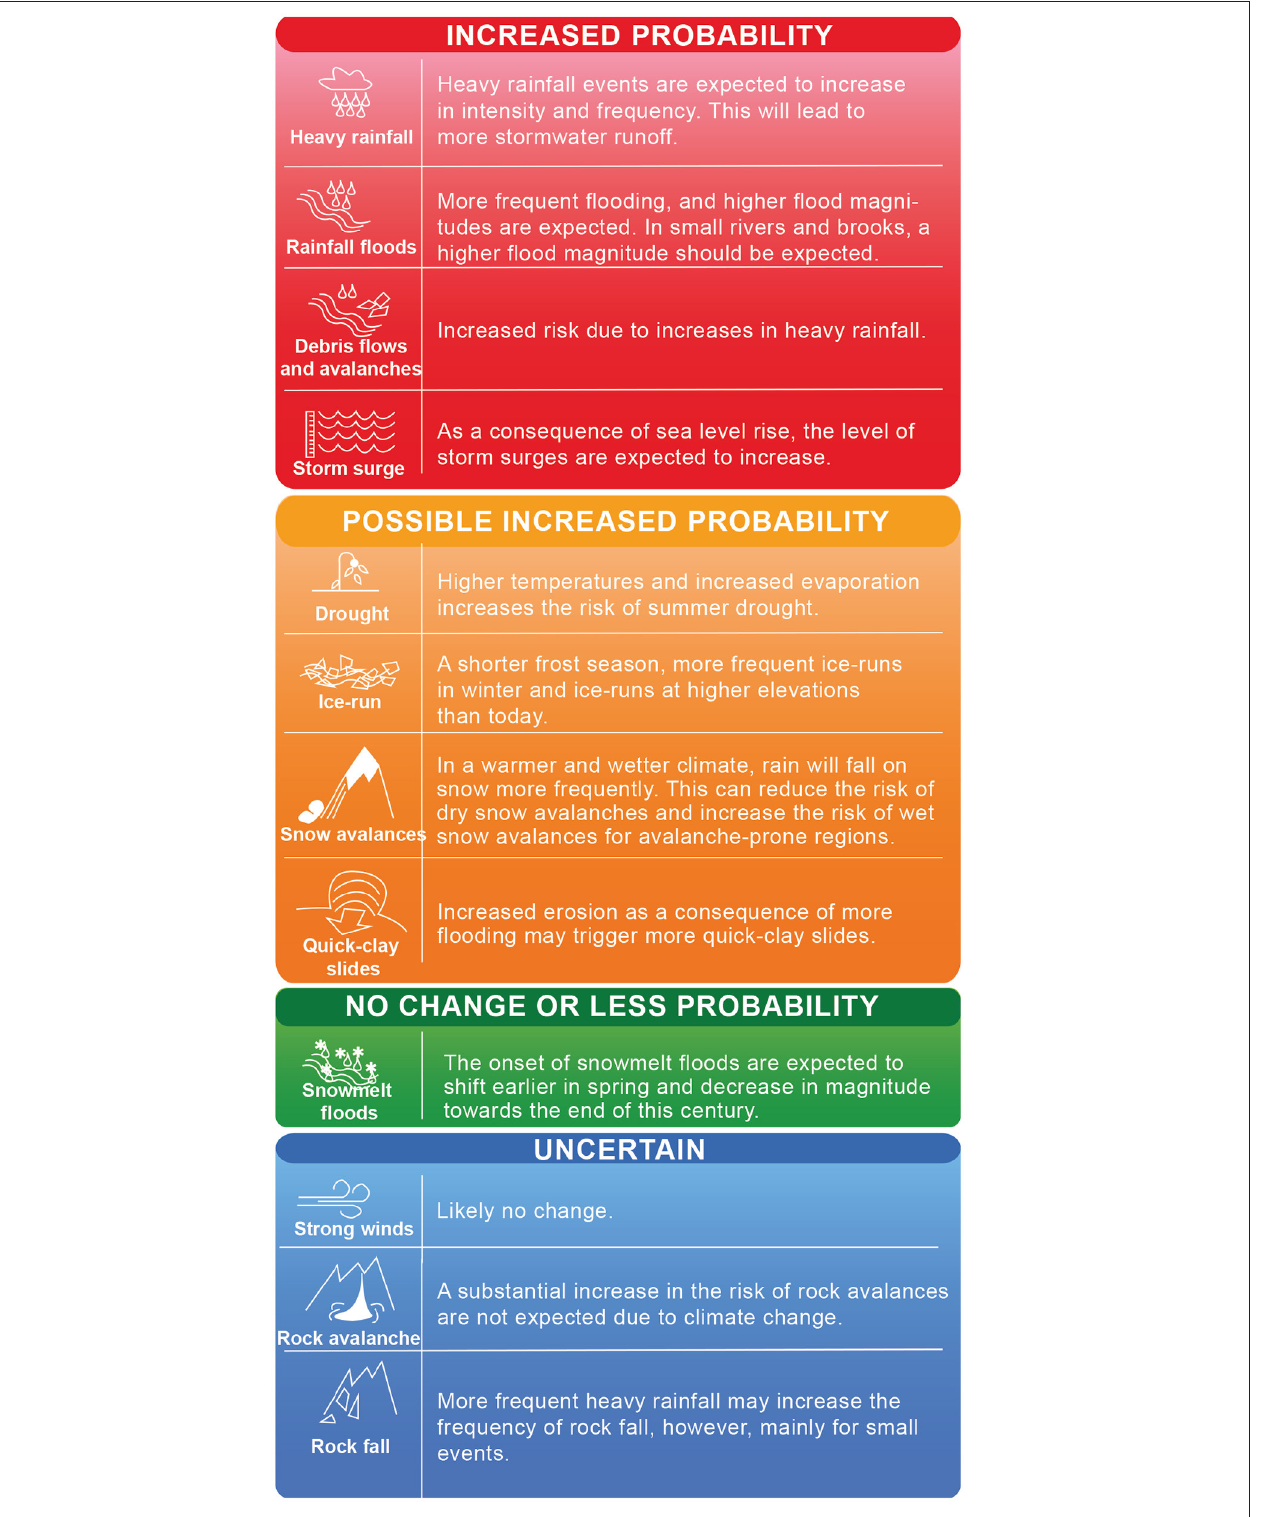
FIGURE 4 | Example factsheet for one county. The factsheet shows a summary of projected changes in hydrological conditions and natural hazards relevant to the county for the period from 1971–2000 to 2071–2100.